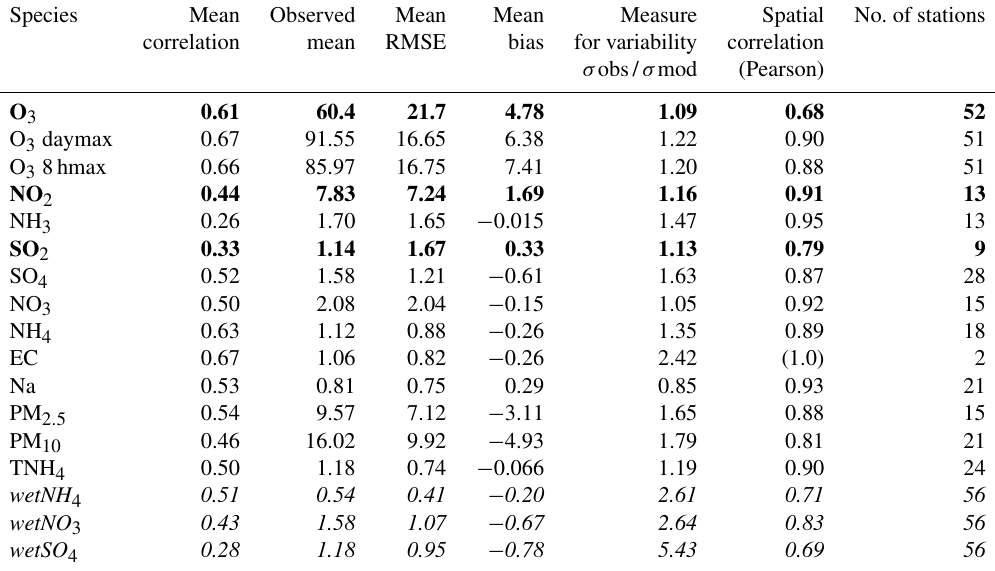
Table 2. Comparison of modelled and measured concentrations of air pollutants. Bold = based on hourly measurements. regular = based on daily measurements, italic = based on monthly measurements. O 3 daymax and 8hmax are based on April–September. Concentrations in air are reported in micrograms per cubic metre (µgm − 3 ). Wet deposition is reported in terms of monthly values of concentrations of SIA in rainwater in milligrams per litre (mgL − 1 ). Mean correlation is mean of time correlation for all stations, spatial correlation is based on annual mean values of all